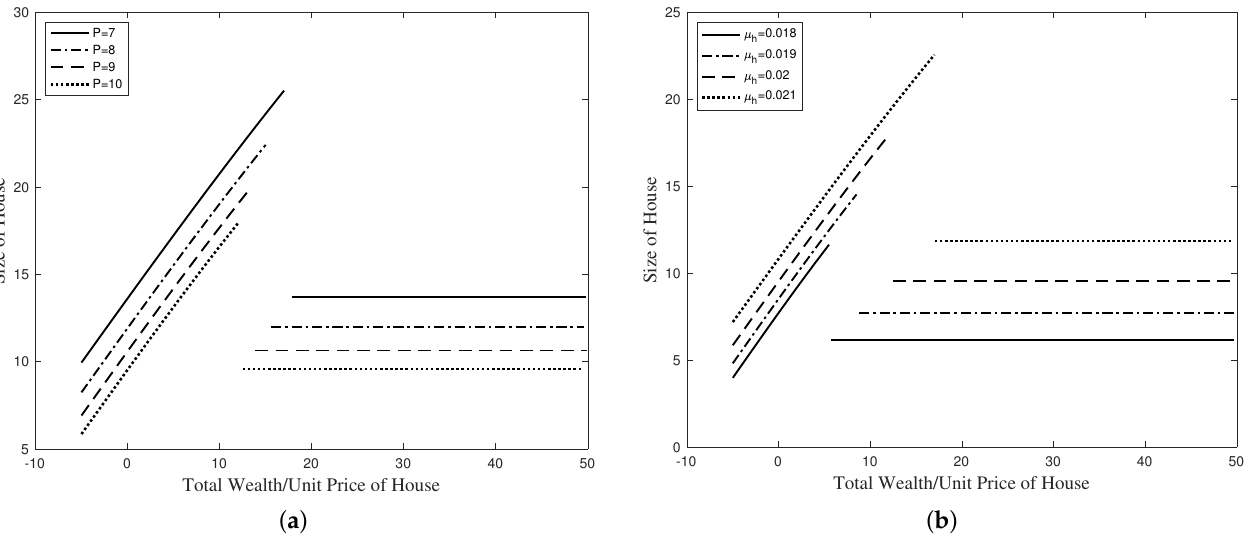
Figure 2. Optimal housing policies with changes in housing price and growth rate of housing price.